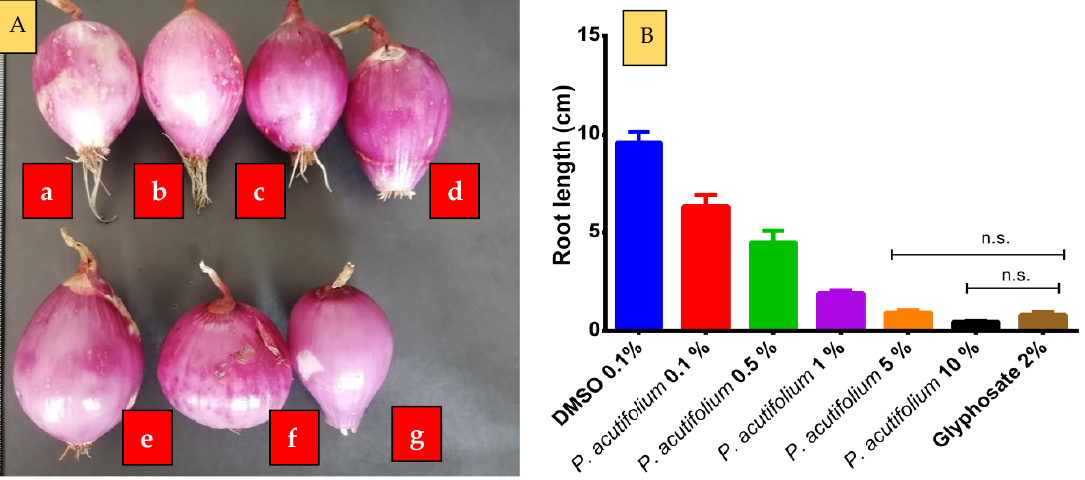
Figure 3. Phytotoxic activity of the essential oil of P. acutifolium on Allium cepa bulbs. ( A ): Morphology of A. cepa roots; a: Negative control (DMSO 0.1%); b: P. acutifolium 0.1%; c: P. acutifolium 0.5%; d: P. acutifolium 1%; e: P. acutifolium 5%; f: P. acutifolium 10%; g: Glyphosate 2%. ( B ): Root length of A. cepa after 10 days of treatment with EO and glyphosate. Notes: n.s.: non-significant.